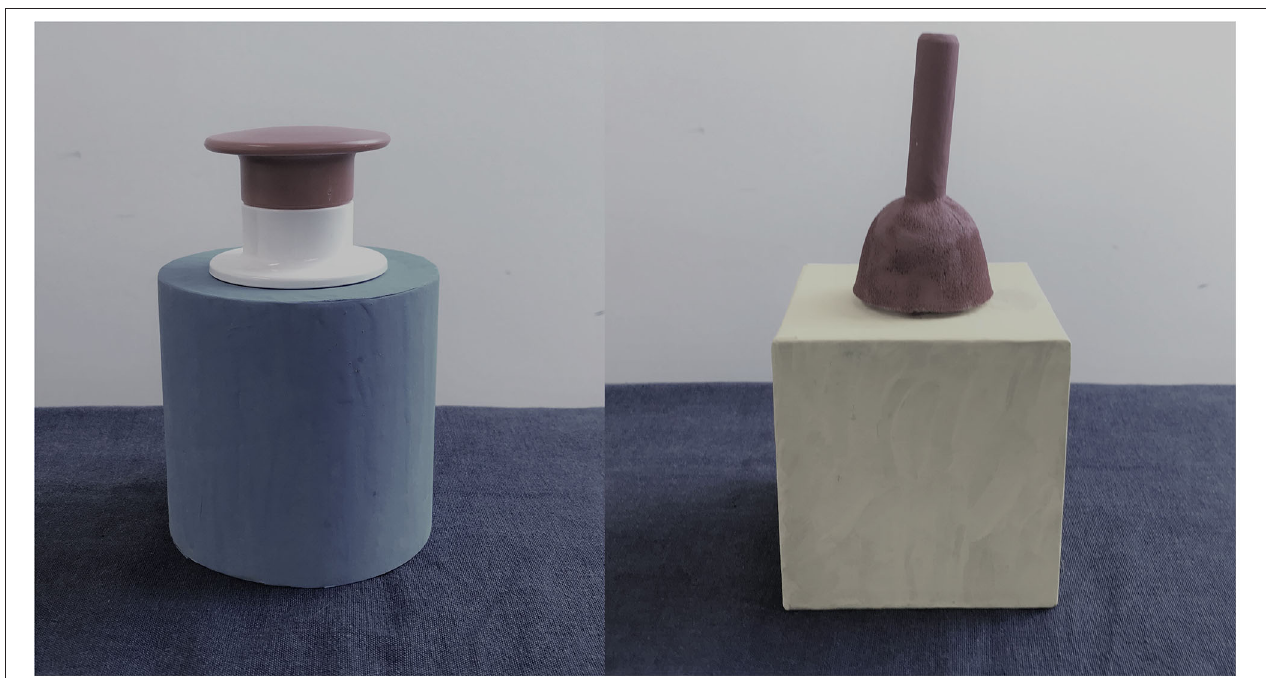
FIGURE 1 | Materials. Picture depicts the objects that were used as “apple slicers” during the study both in Experiment 1 and